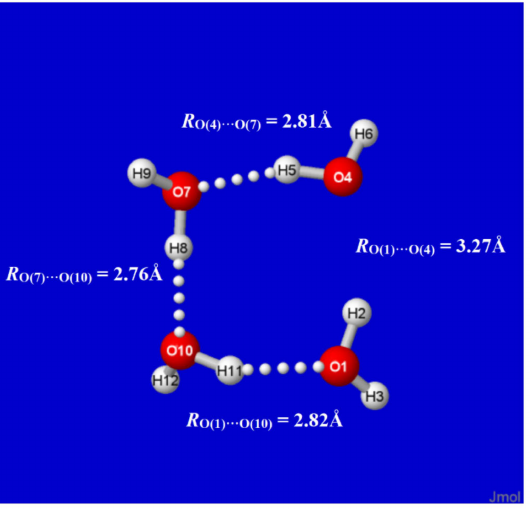
Figure 5. Pre-orthogonal (PNBO) depiction of n O → σ * OH orbital interaction in one H-bond of W 4c , with energetic (kcal/mol) and charge transfer ( e ) details as insets (see text). Alternatively, the effects of n O(4) → σ * O(1)H(2) interaction can be quantified by deleting this single specific matrix element from the DFT calculation (with standard $DEL keylist options [62]) and recalculating the energy and reoptimized geometry as though it were absent in nature. As shown in Figure 6, this single deletion “breaks” the O(4) ··· H(2) − O(1) hydrogen bond (and initial S 4 symmetry) to give an open-chain structure with R O(1) ··· O(4) separation increased by ~0.5 Å to near-van der Waals contact distance. The monomers at each chain terminus also reorient to near coplanarity (contrary to the ~120 ◦ dihedral twist- ing of the two remaining monomers), thereby allowing partial re-gain of n ( σ ) O(4) → σ * O(1)H(2) attraction with the weaker in -plane n ( σ ) O(4) lone pair of O(4). By such $DEL deletion searches, one verifies that the specific n O(4) → σ * O(1)H(2) interaction is the unique “smoking gun” that is both necessary and sufficient for characteristic H-bonding between O(1) and O(4) monomers.